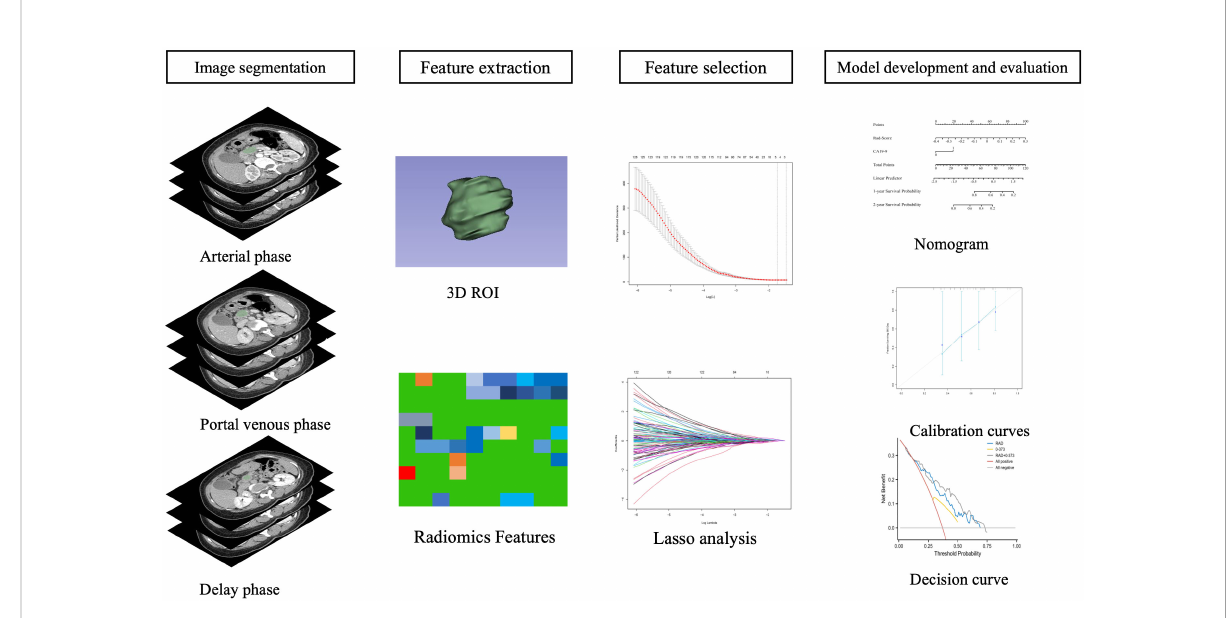
FIGURE 2 Radiomics work fl